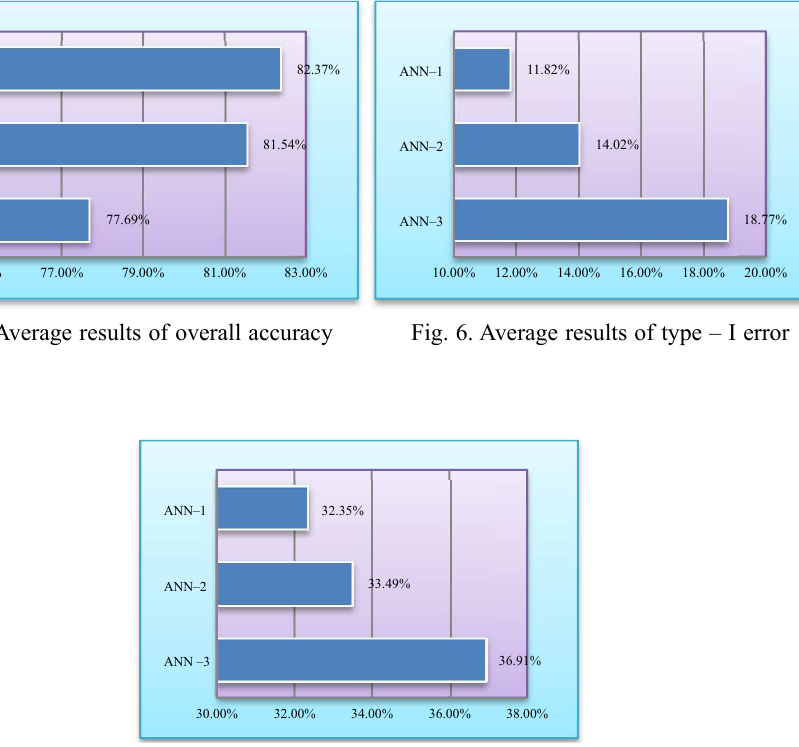
Fig. 7. Average results of type – II